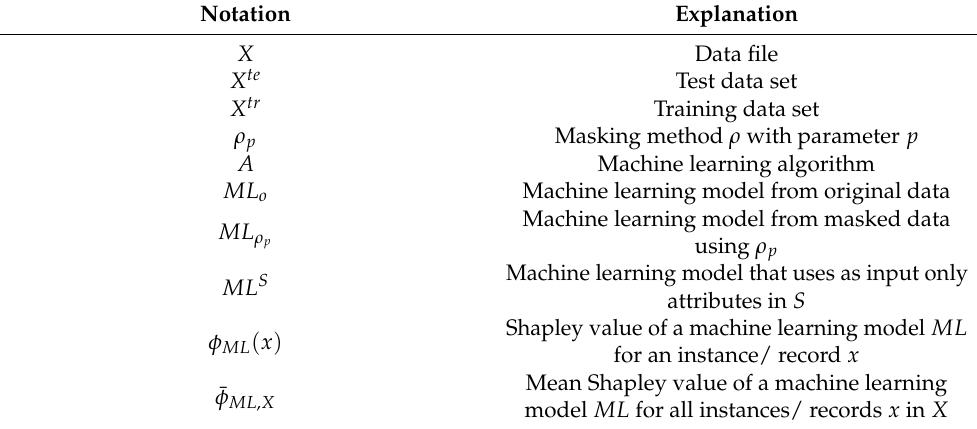
Table 1. Notation